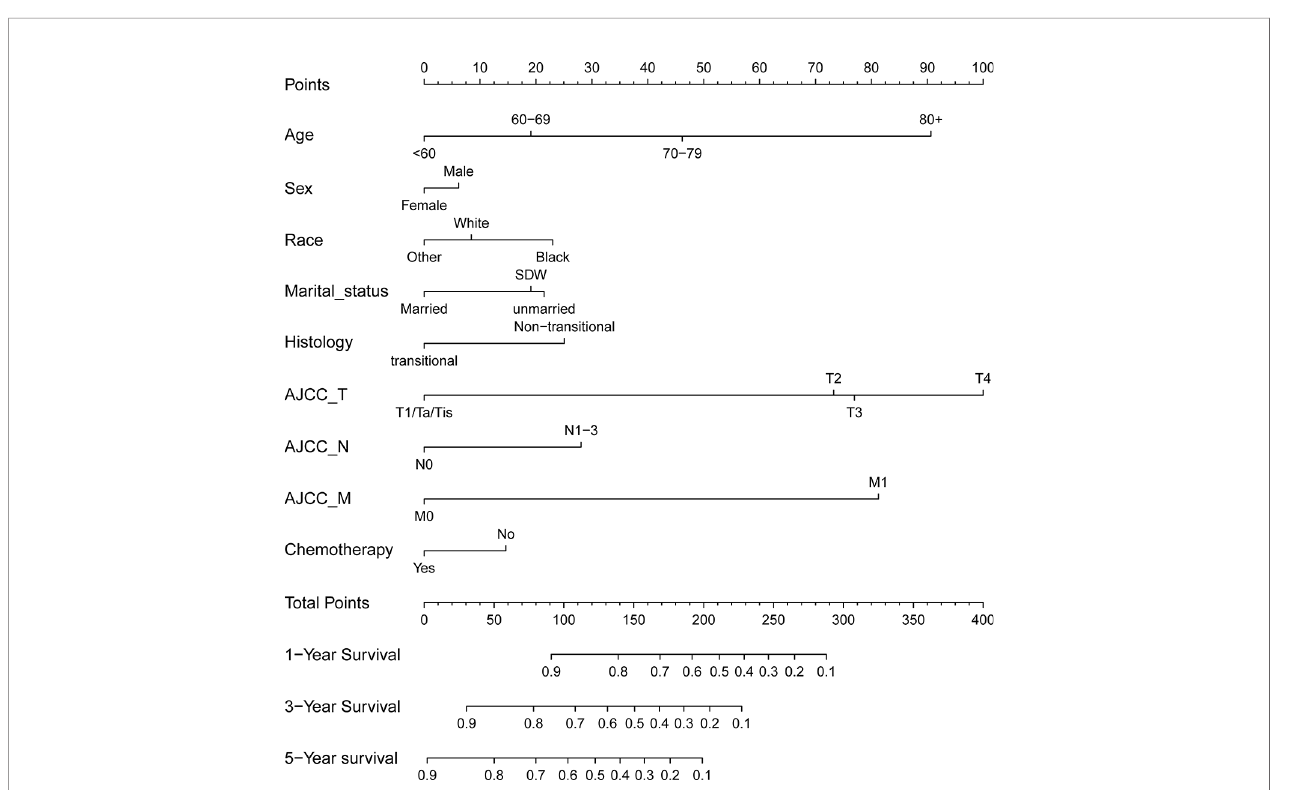
FIGURE 4 | Nomogram for predicting 1-, 3-, and 5-year overall survival rates for BLCA patients. For individual patient, a score was assigned based on each factor in the nomogram, and total points could be calculated and corresponded vertically to survival probability using the